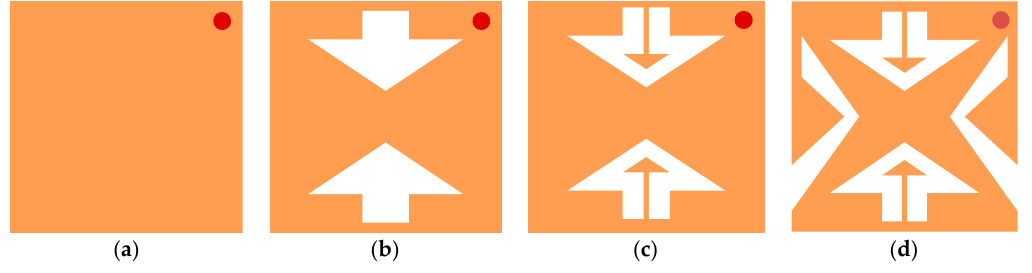
Figure 5. Evolving structures of the proposed antenna in: ( a ) Case 1; ( b ) Case 2; ( c ) Case 3; and ( d ) Case 4.